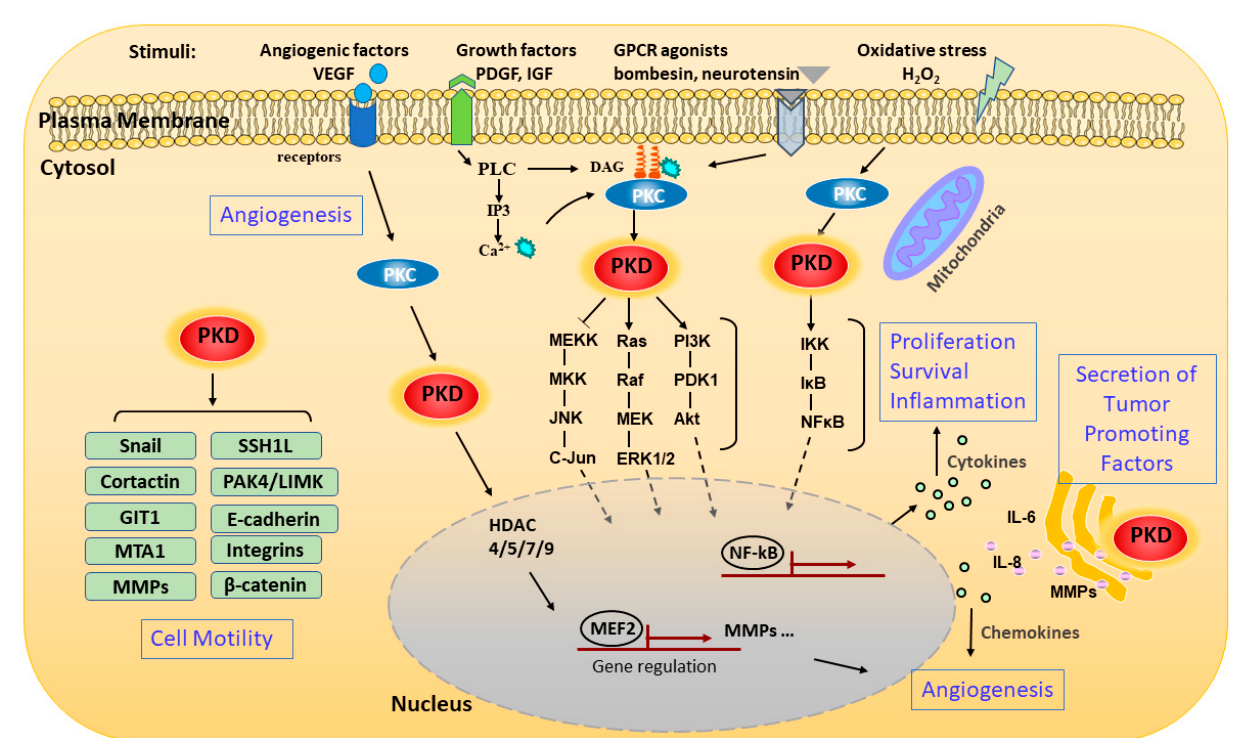
Figure 2. Schematic representation of signaling pathways and pathological processes regulated by PKD. The schematic representation shows the pathways that activate PKD and the various downstream signaling events and functions modulated by the kinase. PKD can be activated through stimulating various membrane receptors such as G-protein-coupled receptors (GPCRs) and growth factor receptors. The extracellular stimuli activate phospholipase C (PLC), which catalyzes the formation of diacylglycerol (DAG). DAG modulates PKD activation by binding and recruiting it to the cell membrane for activation by protein kinase C (PKC). PKD can also be activated on the outer mitochondrial membrane by oxidative stress through binding to DAG and PKC. Activated PKD is rapidly translocated from the plasma membrane to the cytosol and then to the nucleus, where it regulates a set of transcription factors in the nucleus. Activated PKD regulates a battery of pathological processes including cell proliferation, survival, migration, invasion, gene transcription, inflammation, angiogenesis, and secretion of tumor-associated factors through several major signaling pathways. Abbreviations: matrix metalloproteinase (MMP), vascular endothelial growth factor (VEGF), platelet-derived growth factor (PDGF), insulin-like growth factor (IGF), metastasis-associated 1 (MTA1), slingshot-1L (SSH1L), GPCR kinase-interacting protein 1 (GIT1).